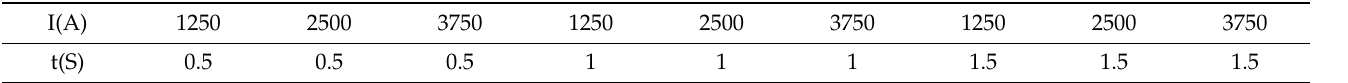
Table 2. Taguchi L9 design for current and time